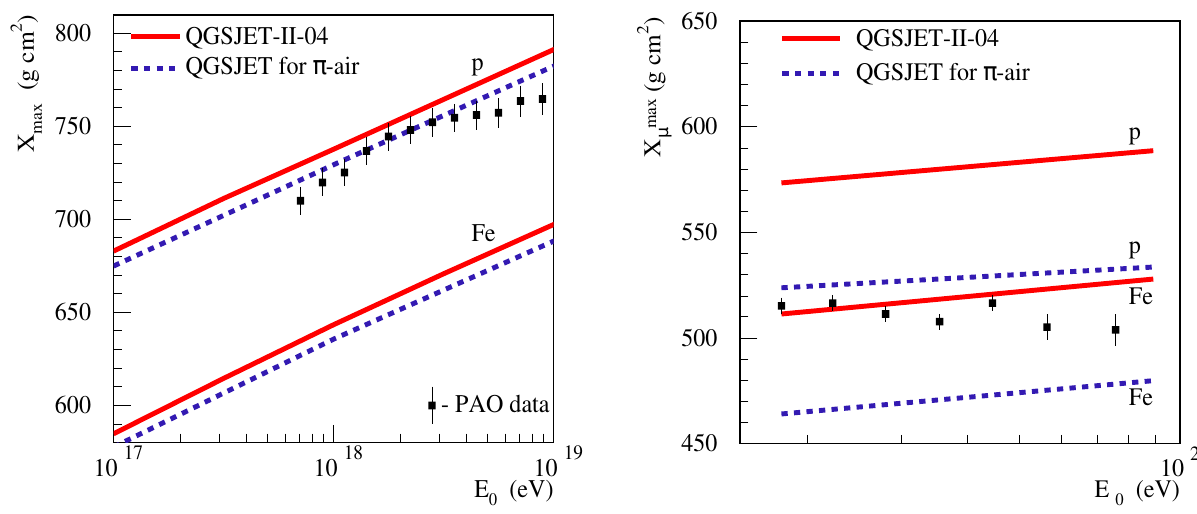
Figure 6. Primary energy dependence of X max (left) and X µ max (right) for proton- and iron-induced vertical EAS, as calculated using the QGSJET-II-04 model (solid lines) or applying QGSJET-II-04 for the treatment of (anti-)nucleon-air collisions and QGSJET for the description of pion-air and kaon-air interactions (dashed lines). PAO data [23, 31] are shown by squares.